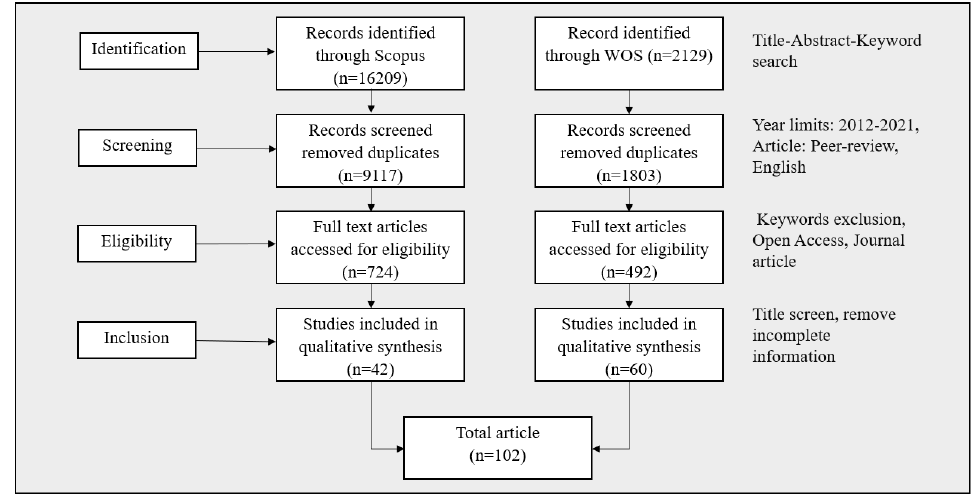
Figure 4. MLBDD article selection procedure used in this study.